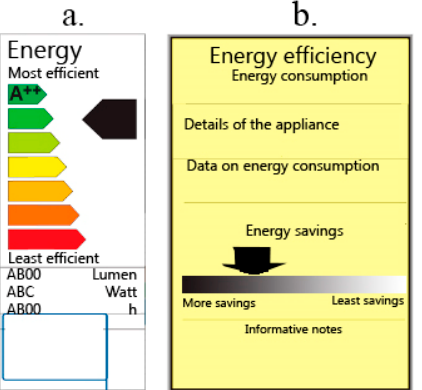
Figure 6. Two types of energy labelling stamps used in the reviewed countries, showing the comparative ( a ), and the scalar ( b ) types. ( a ), and the scalar ( b )